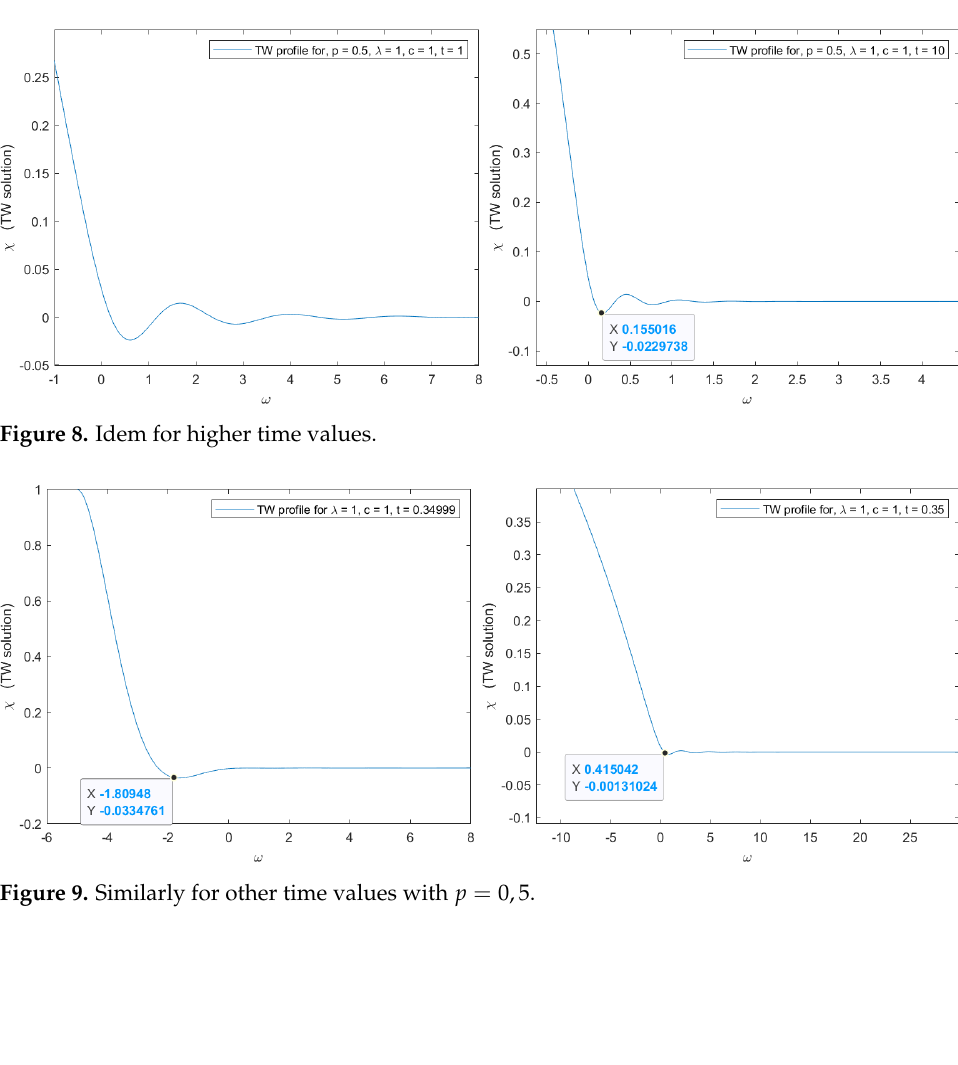
Figure 7. Travelling wave profile evolution for p = 0.5. It is possible to observe that the first minimum is negative for each given time.